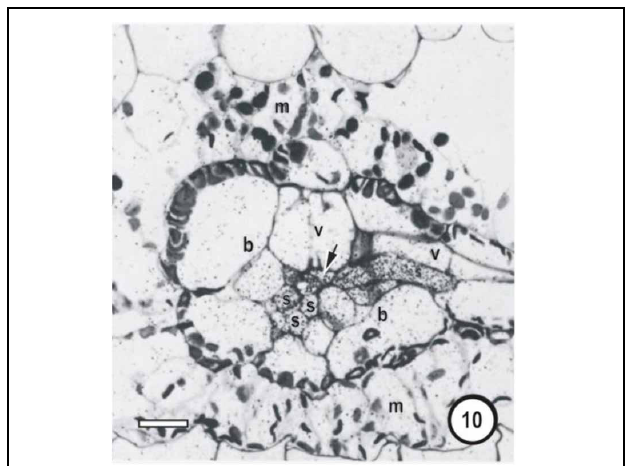
FIGURE 10 | Microautoradiographs of small vascular bundles in a Zea mays leaf and portions of transverse veins after 5min feeding with 14 CO 2 , followed by a 10-min 12 CO 2 chase showing accumulation of the 14 C label in thick- and thin-walled sieve tubes. Label has accumulated in phloem cells as well as being transferred to an emergent thick-walled transverse vein sieve tube to the right, which enters the small bundle at the level of the thick-walled sieve tube.